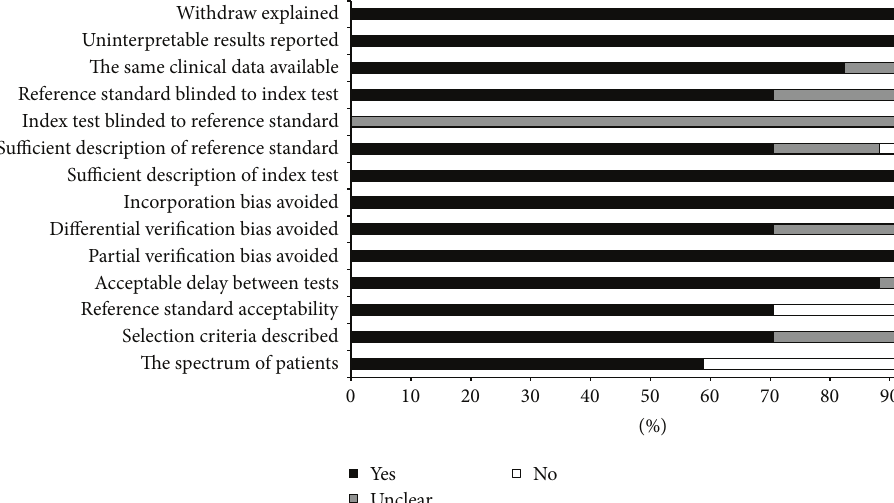
approach of assaying anti-CCP antibodies. However, they did not definitively report whether the assessors of the anti- CCP assay results were blinded to the reference